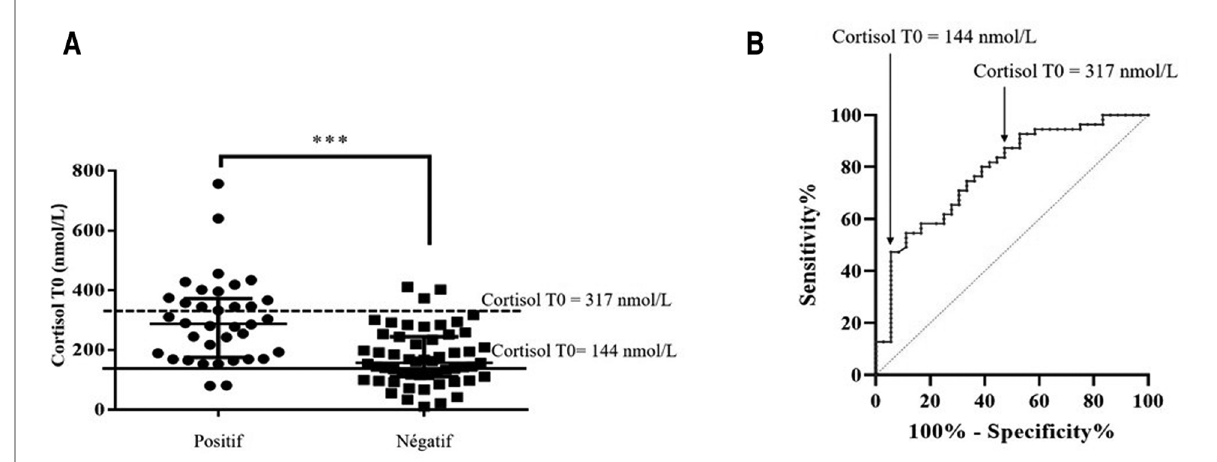
FIGURE 3 Morning plasma cortisol levels according to the result of the LD-SST (A) morning plasma cortisol value was associated to the LD-SST (ANOVA, *** p < 0.0001). LD-SST was considered positive when cortisol at T20 raised above 500 nmol/l otherwise it was considered negative. The full line represents the value associated with GI-AI (Se=0.47, Sp=0.94). The dotted line represents the value associated with a Normal response to LD-SST (Se=0.95, Sp=0.42). B) ROC curve for morning plasma cortisol level with LD-SST as the reference test. Area under the curve is 0.7795 (IC95 [0.69; 0.88], p